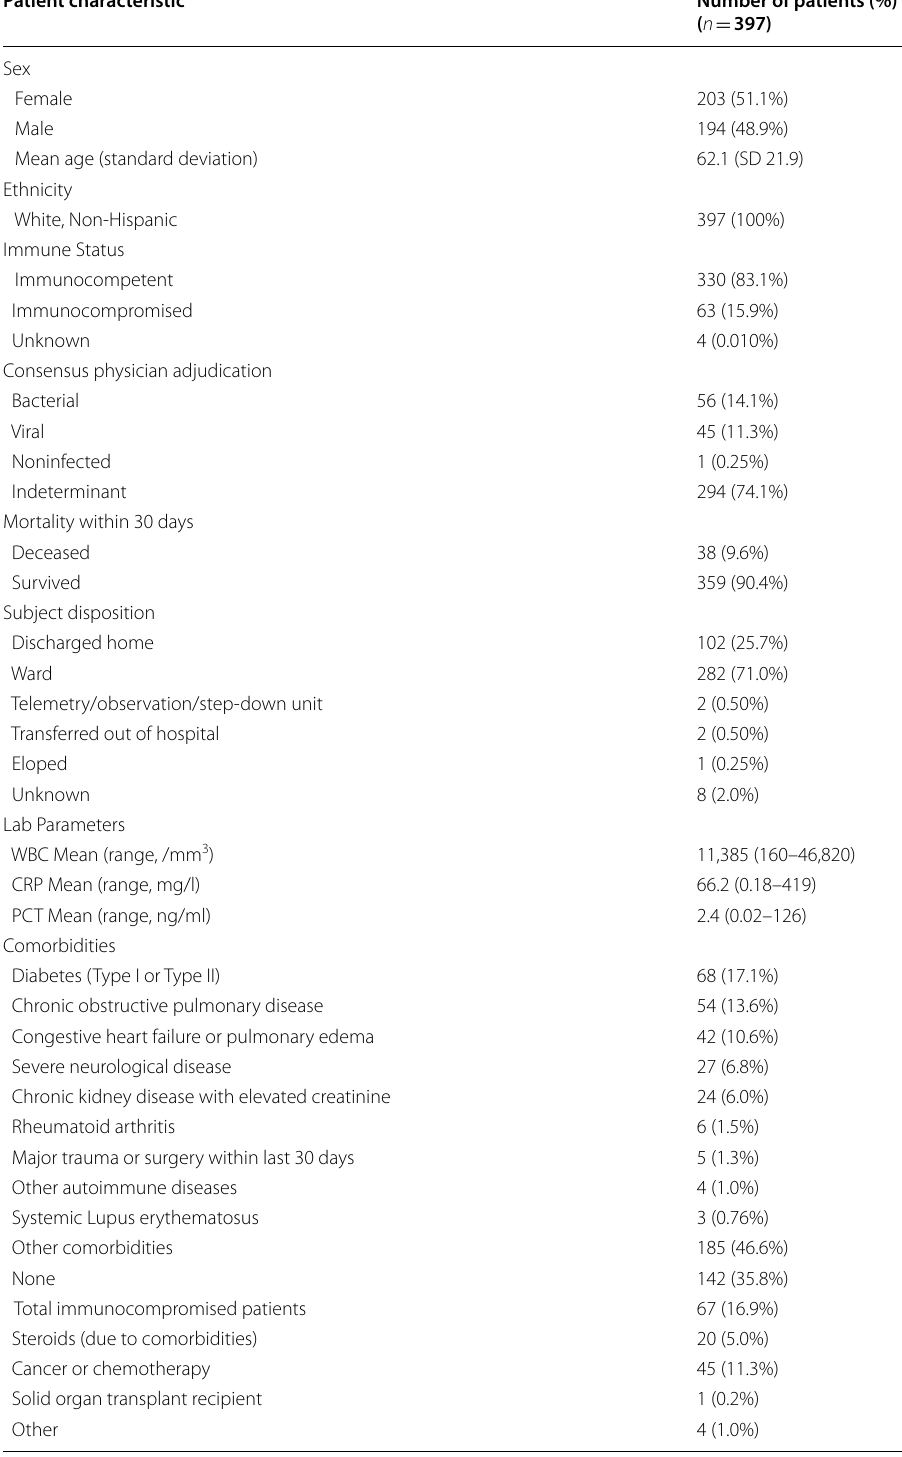
Table 1 Patient